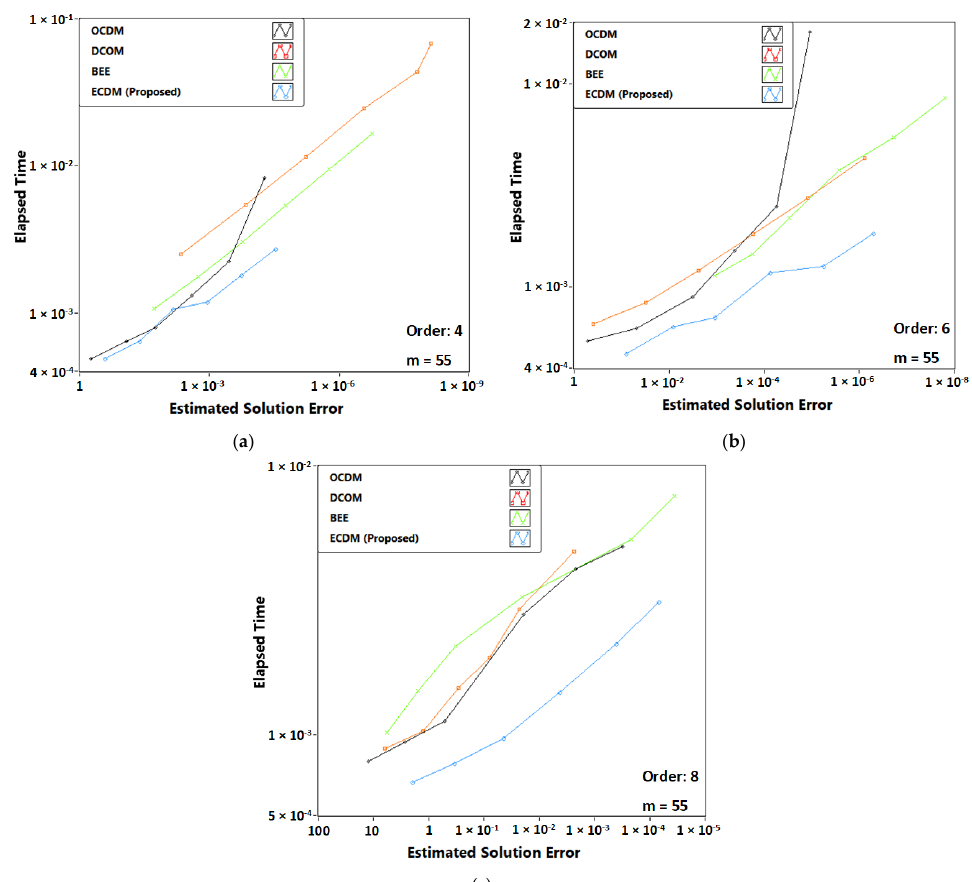
Figure 6. Performance plots for Van der Pol oscillator simulation by solvers of orders 4 ( a ), 6 ( b ), and 8 ( c ).